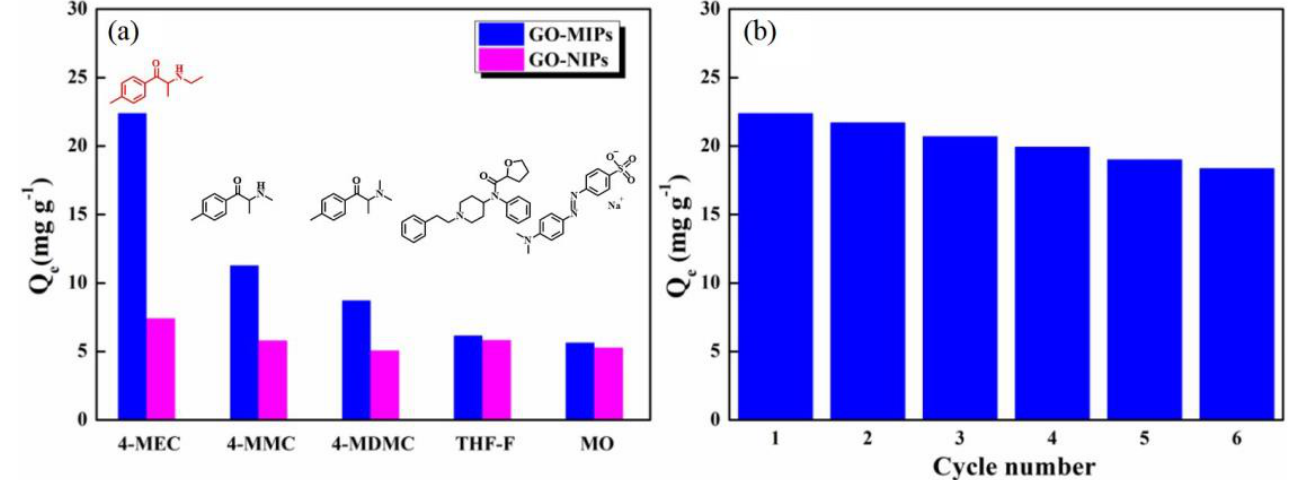
Figure 6. The selectivity of the GO-MIPs and GO-NIPs for adsorption of 4-MEC and interferents in aqueous medium ( a ), and repeatability experiments of GO-MIPs over six cycles of adsorption– desorption in methanol of the extraction at ambient temperature ( b ).